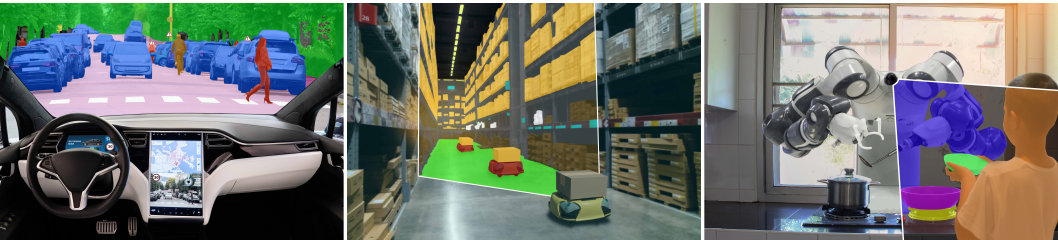
Figure 3. Autonomous cars, industry robots and home assistant robots are just some of the possible real world applications of Unsupervised Domain Adaptation (UDA) in semantic segmentation. (The images are modified version of pictures obtained with kind permission from Shutterstock, Inc., New York, NY, USA. The original versions have been created (from left to right) by Scharfsinn, Monopoly919 and